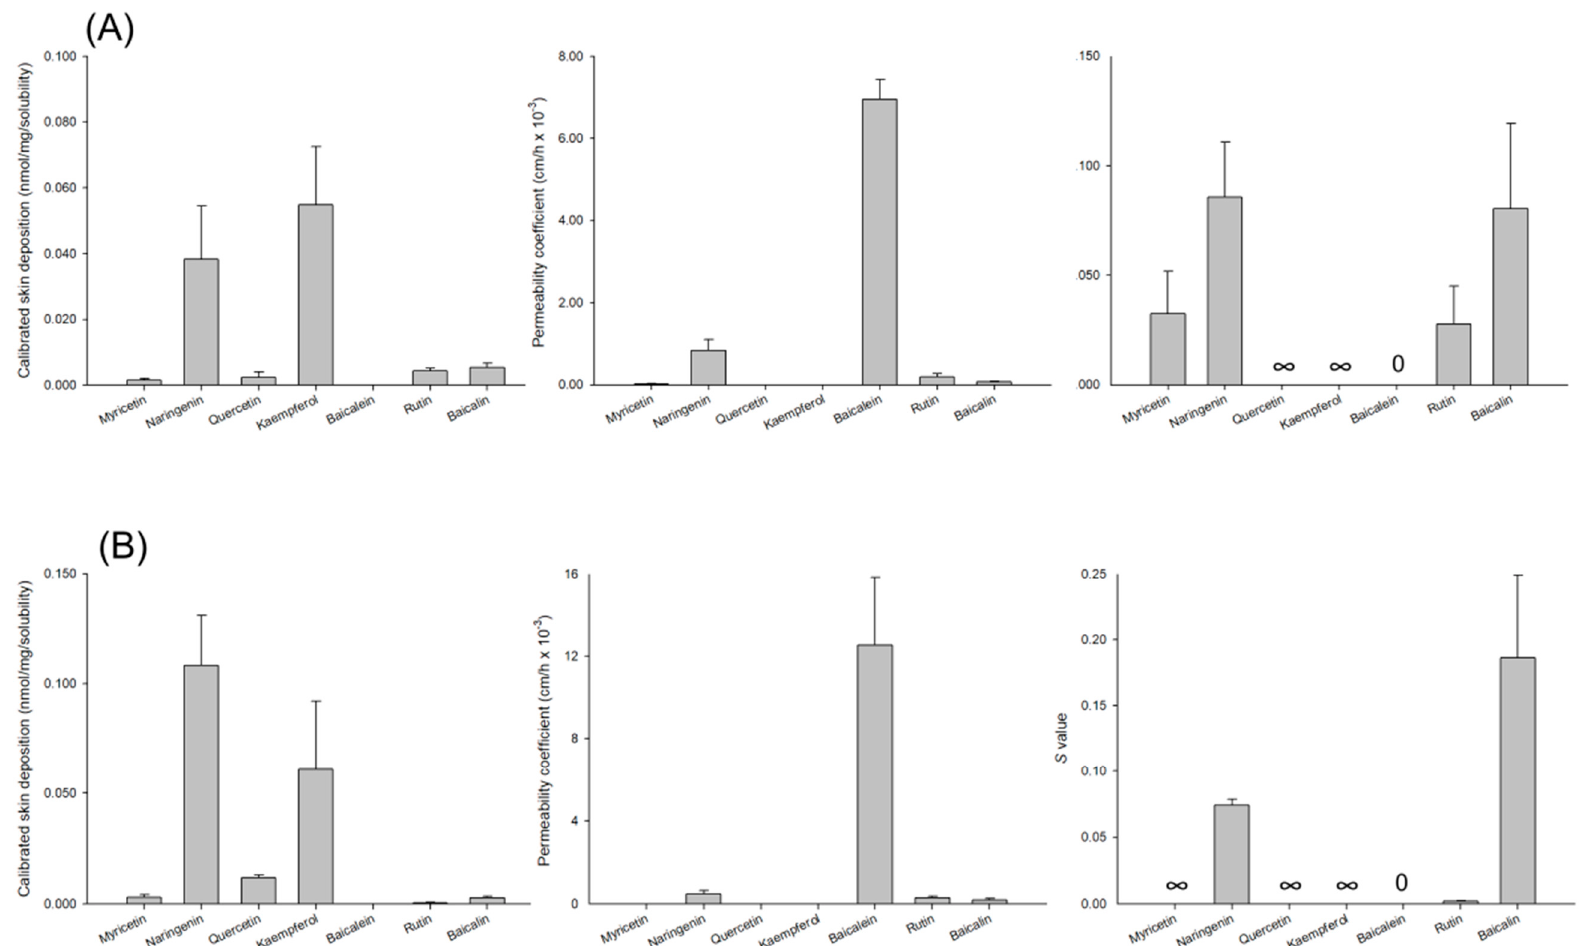
Figure 3. Calibrated skin deposition, permeability coefficient, and S value of flavonoids at a dose of saturated solubility after topical treatment on nude mouse and pig skins: ( A ) nude mouse skin; and ( B ) pig skin. The donor vehicle is 20% PEG400 in pH 7.4 buffer. All data are presented as the mean of four experiments ± S.D.